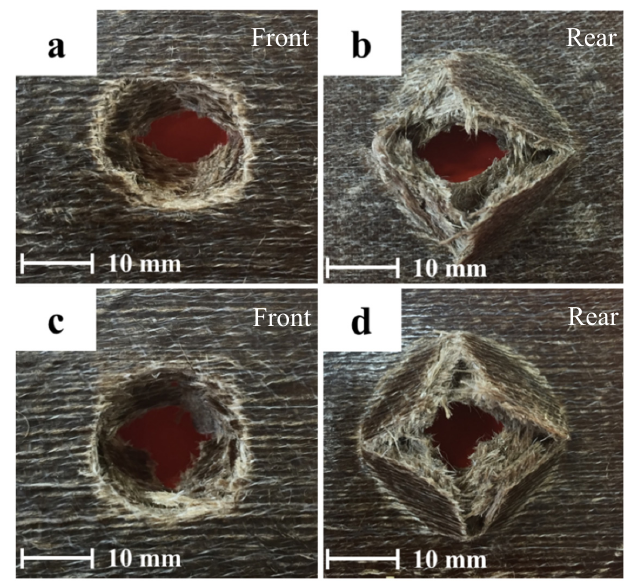
Figure 12. Images of damage progression on front and rear faces of flax/VE composite panels impacted in the range of ( a , b ) 50 J and ( c , d ) 70 J after water absorption.